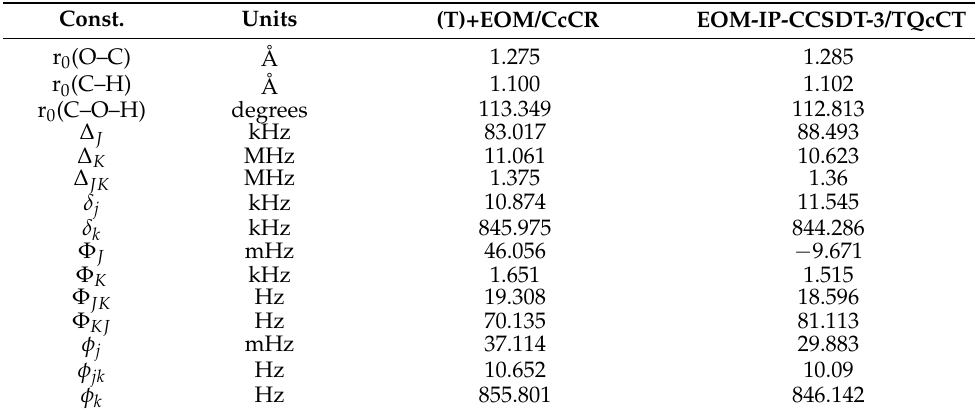
Table A10. ˜B 2 A 1 H 2 CO + Distortion Constants and Geometrical Parameters.